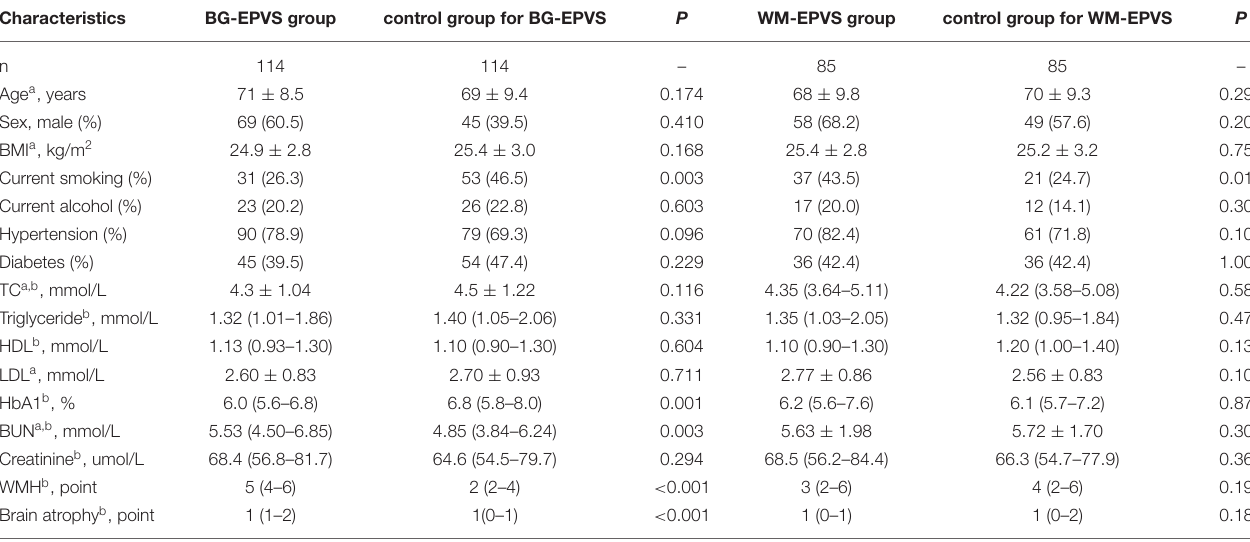
TABLE 1 | General clinical characteristics of participants.